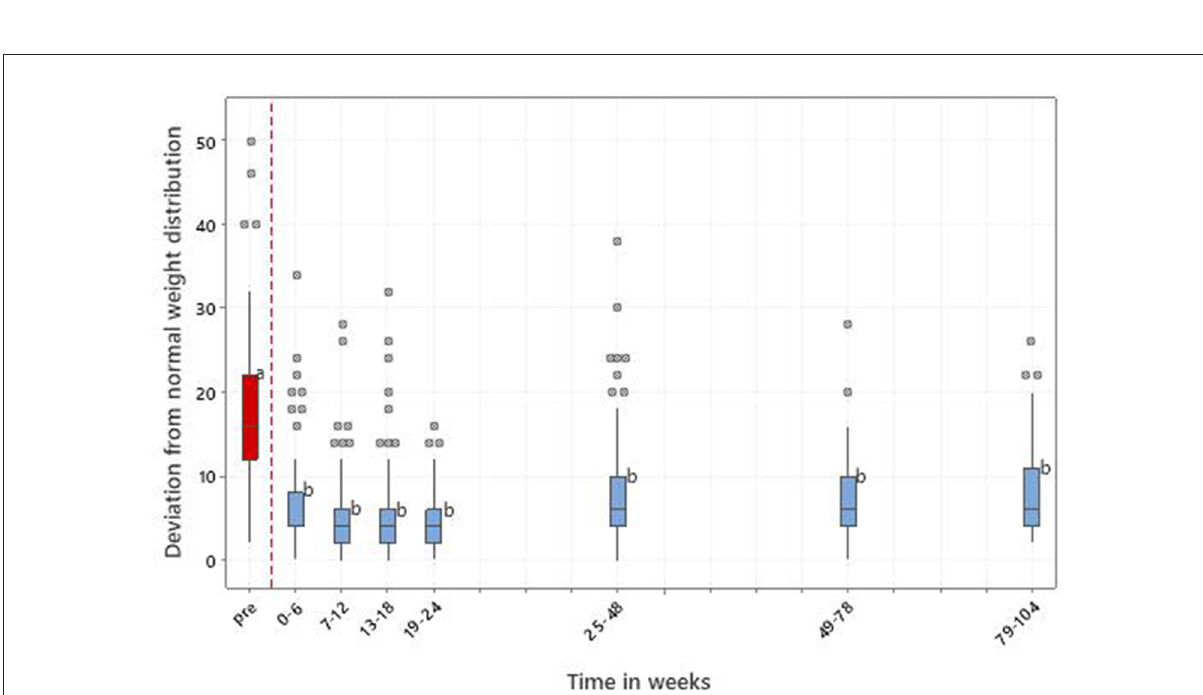
FIGURE6 Results of stance analysis for 228 dogs with MSD treated with RM in time windows representing pretreatment (pre) and up to 104 weeks post initial treatment. 0 = perfect balance; > 0 = increasing imbalance. It should be noted that in this figure a single value of 78 in time window 7–12 weeks was removed in order to improve the use of the vertical space. This value related to a dog that had an acute traumatic incident resulting in non-weight bearing lameness, unrelated to its original diagnosed pathologies. The dog improved with rest and supplemental analgesia and its weight distribution normalized after 7 days. Letters adjacent to each bar indicate which time windows are significantly different (i.e., those not sharing a common